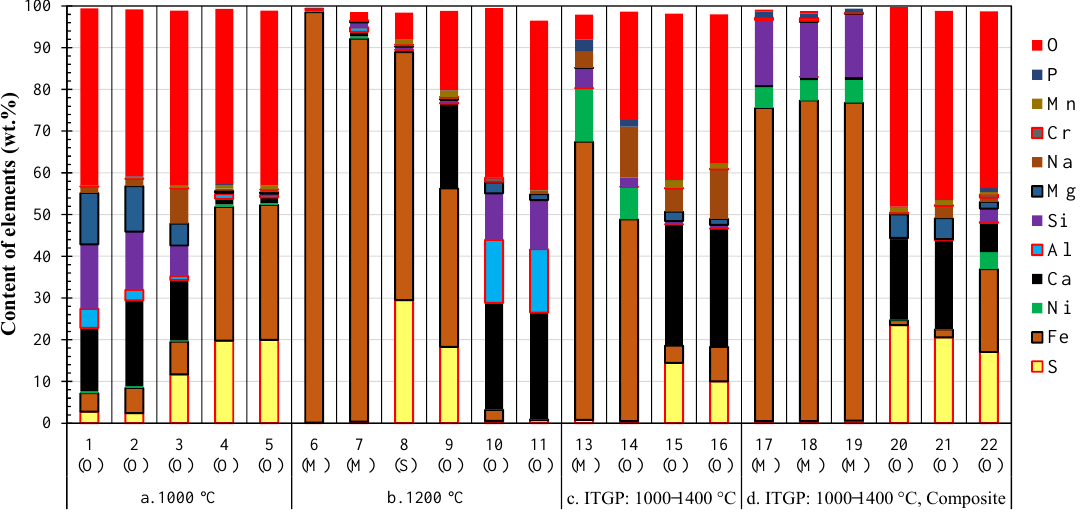
Figure 9. EDS analysis of unroasted natrojarosite residue after carbothermic reduction at different temperatures; ITGP = isothermal temperature gradient pattern. Numbers 1 – 22 refer to the location in Figure 8, O = oxide, M = metal, S = sulfide.